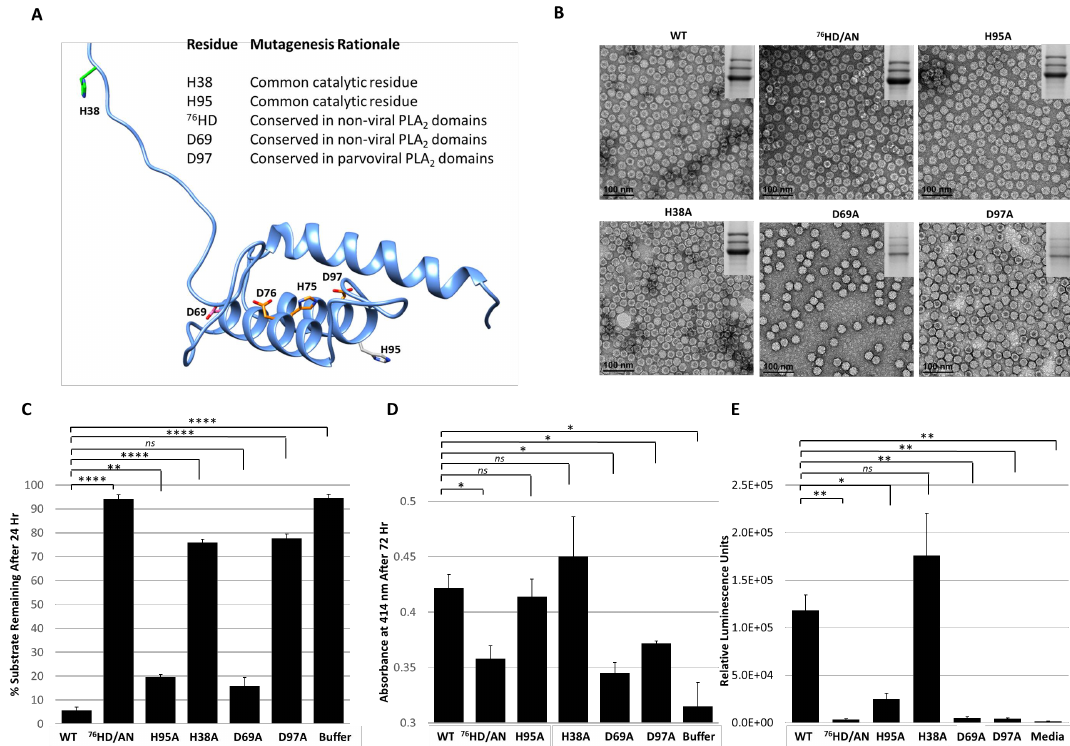
Figure 6. Functional phenotypes of AAV2 VP1u variants. ( A ) Location of amino acid substitutions in the AAV2 VP1u listed and shown in stick representation on a RaptorX model. Residues colored in orange represent those with PLA 2 and protease defects when substituted, pink for defect to PLA 2 only, green for defect to protease only and gray for no defect to either PLA 2 or protease function. ( B ) Negative-stain EMs of wt AAV2 and variant capsids, confirming the capsid assembly of the viruses. SDS-PAGE gel insert shows expression of VP1, VP2 and VP3; ( C ) Quantification of the proteolysis of a casein substrate by wt AAV2 and the variants listed ( x -axis) after 24 h. The y -axis is as described in Figure 2. ( D ) PLA 2 activity of wt AAV2 and variants. The y -axis depicts the level of lipid modification after 72 h at pH 8.0 and x -axis lists the samples tested. ( E ) Luciferase reporter activity expression (RLU) for wt AAV2 and variants. The y -axis depicts the relative luminescence units and x -axis lists the samples tested. Statistical significance of asterisk annotations (*) are described in Material and Methods